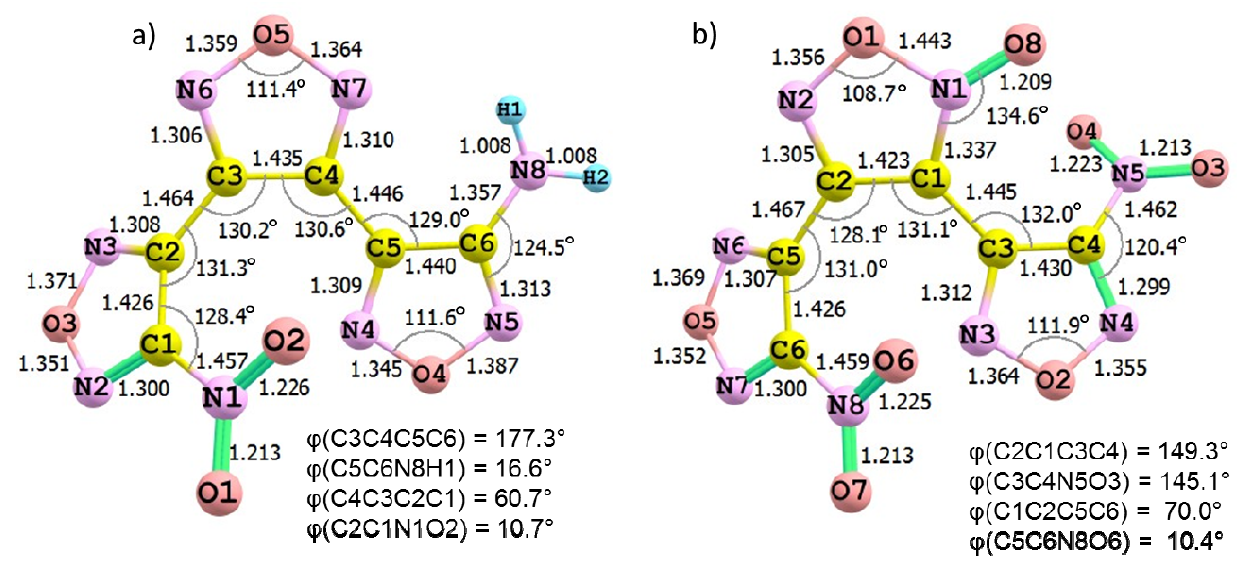
Figure 1. Geometry structures of ( a ) ANFF-1 and ( b ) BNFF molecules were obtained from Density Functional Theory modeling in the B3LYP/6-31+G(2df,p) approximation. The bond distances are shown in